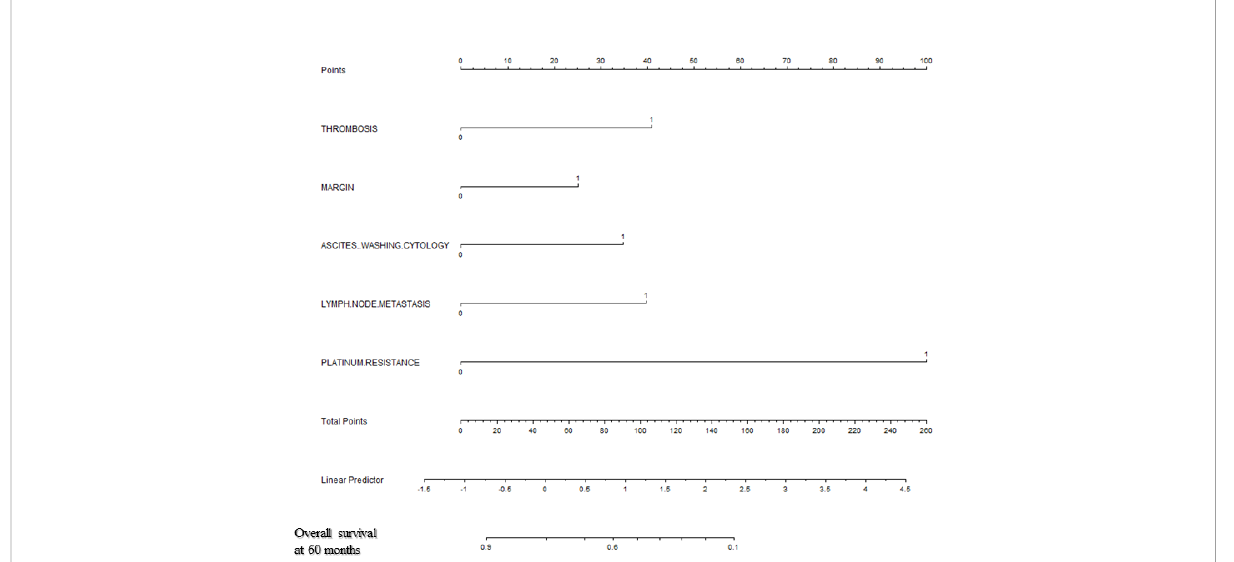
FIGURE 2 A Nomogram for Predicting Overall Survival of Patients With Resectable Ovarian Clear Cell Carcinoma After Primary Treatment. To calculate predicted overall survival, an individual patient ’ s value is located on each variable axis, and a straight line is drawn upward to the “ Points ” row to determine the points associated with each factor. After summing the total points, one locates the appropriate total point number and draws a straight line from this to the bottom rows to determine the patient ’ s predicted survival probability. (For each variable: Thrombosis: 0=no thrombosis, 1=exist; Residual of the tumor: 0=negative, 1=positive; Malignant ascites/washing: 0=no malignant ascites/washing, 1= malignant ascites/washing; Lymph node metastasis: 0=negative lymph node metastasis, 1=positive lymph node metastasis; Platinum resistance: 0=platinum sensitive, 1=platinum resistant).